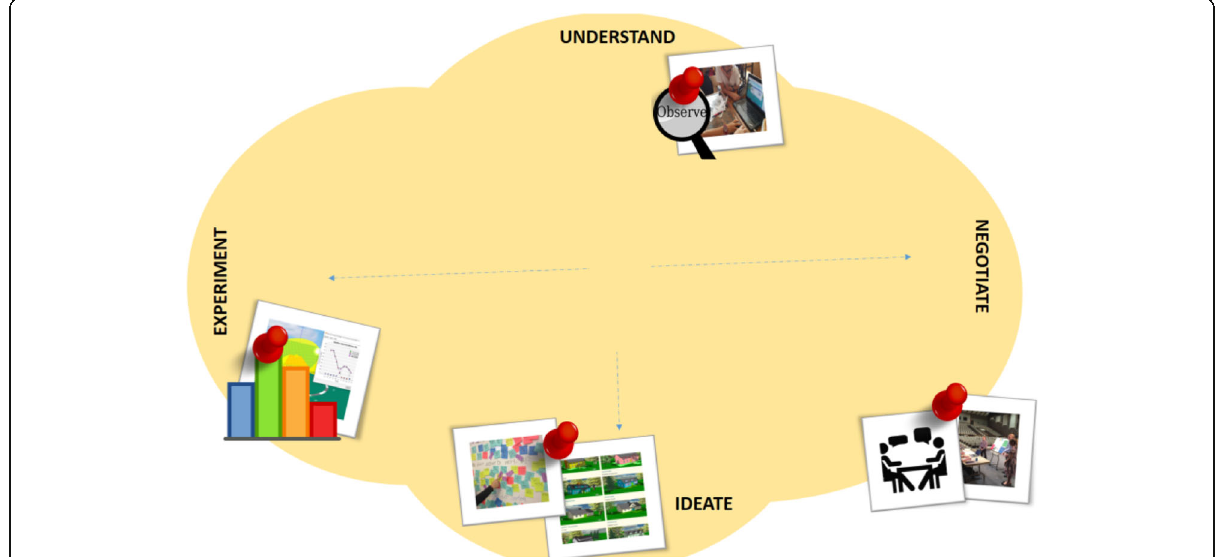
Fig. 2 Design Canvas: An instructional tool that facilitates methodological